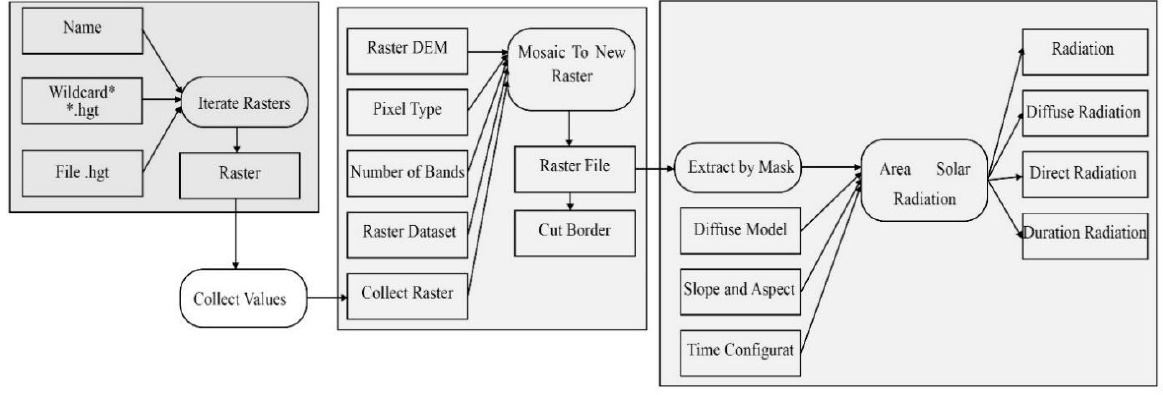
Figure 3. Algorithm of the generated tool for calculating solar radiation using radar